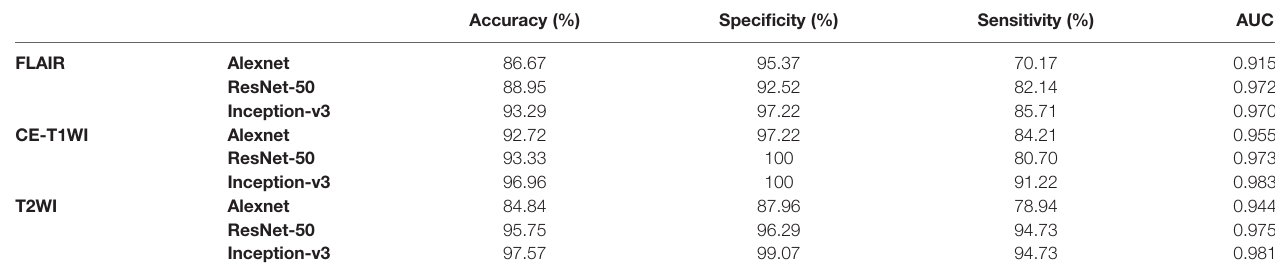
AUC, the area under the receiver operator characteristic curve.